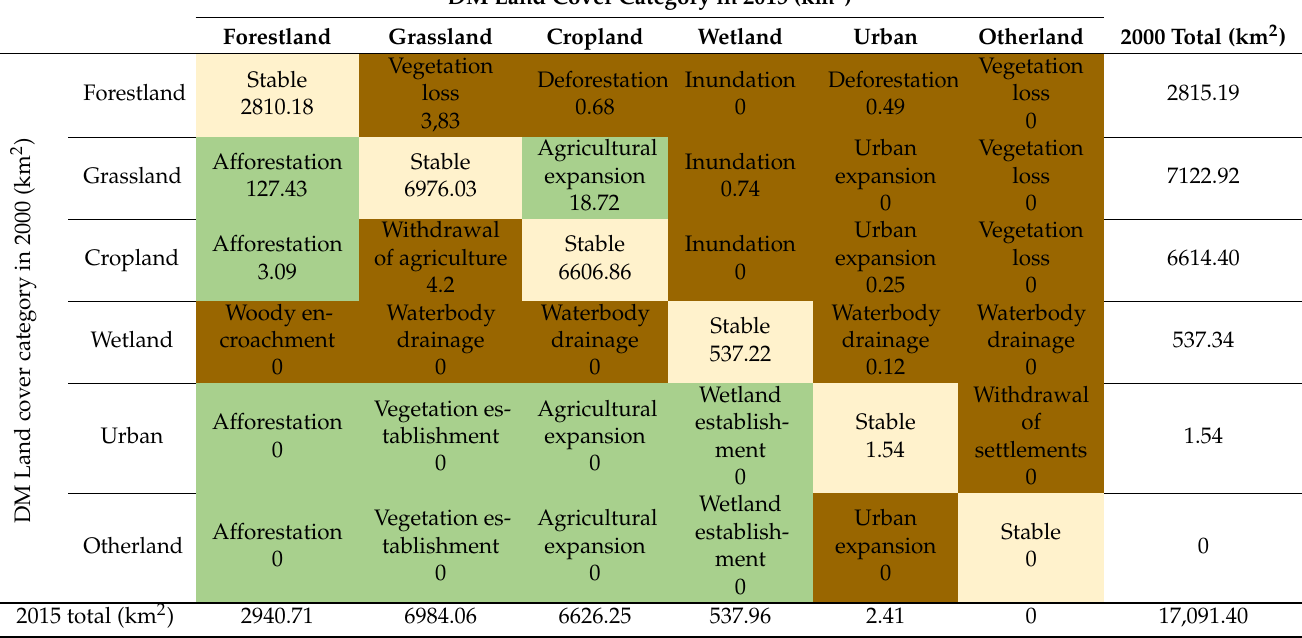
Table A1. Land cover transition matrix (2000–2015) based on the default methods (DM). Green, beige and brown colors indicate improving, stable and declining conditions of land cover categories, respectively. The area in km 2 and the possible cause of the land cover transition are indicated in the matrix. The change is based on the moderate-resolution land cover dataset.